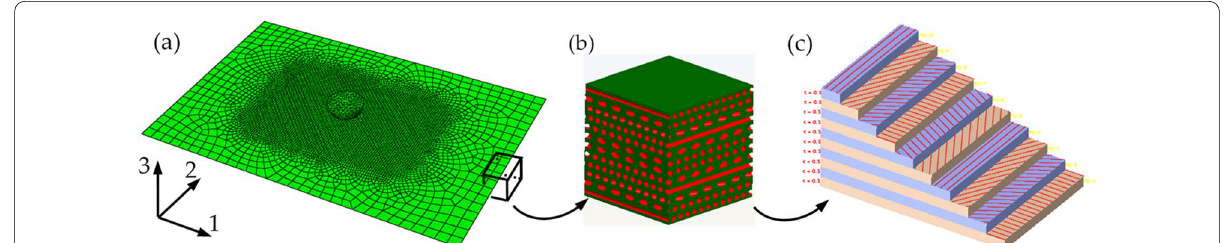
Fig. 2 FE model of bionic composite. a Finite-element model for impact analysis of periodic helical bionic structure, b local enlarged view of the model (red represents fiber and green represents matrix), and c direction of fiber arrangement of